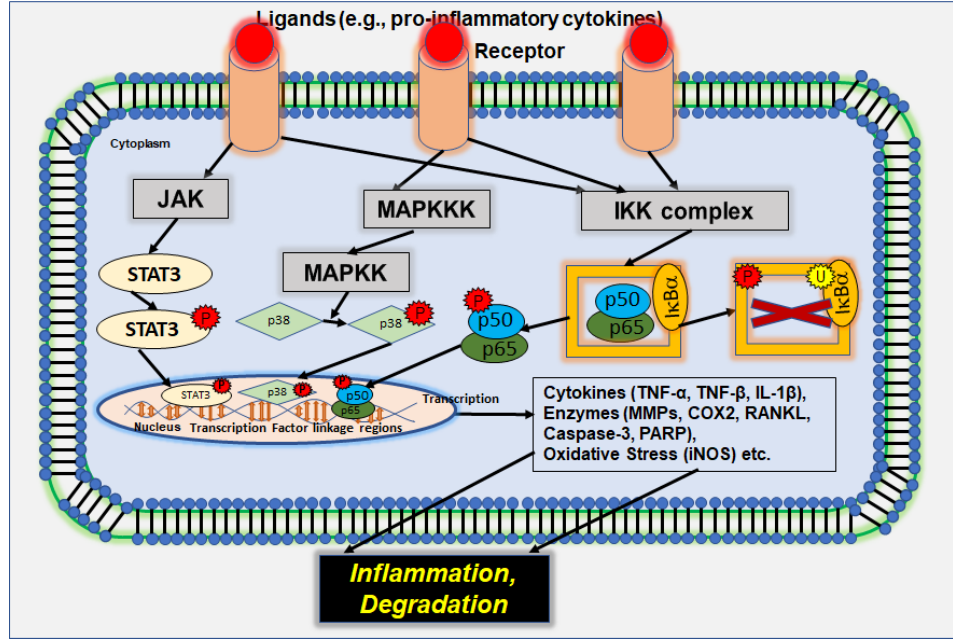
Figure 2. Molecular backgrounds of NF- κ B, STAT3, p38/MAPK signaling linking inflammation, and degradation. Under physiological conditions, NF- κ B is located as a heterodimeric complex of p50 and p65 bound to its inhibitor I κ B α in the cytoplasm. The upstream IKK complex can activate I κ B α by its phosphorylation and ubiquitin-dependent degradation, leading to NF- κ B release that is then activated (p65- NF- κ B) and translocates into the nucleus to activate the transcription of target genes, including cytokines and pro-inflammatory enzymes. The activation of the p38/MAPK signaling pathway by upstream MAPKK is promoted by external stimuli linked to stress and inflammation, binding to various receptors. Activated p38 in turn results in the transcription of several pro- inflammatory genes, such as COX-2, iNOS, MMPs, or RANKL, which are strongly involved in